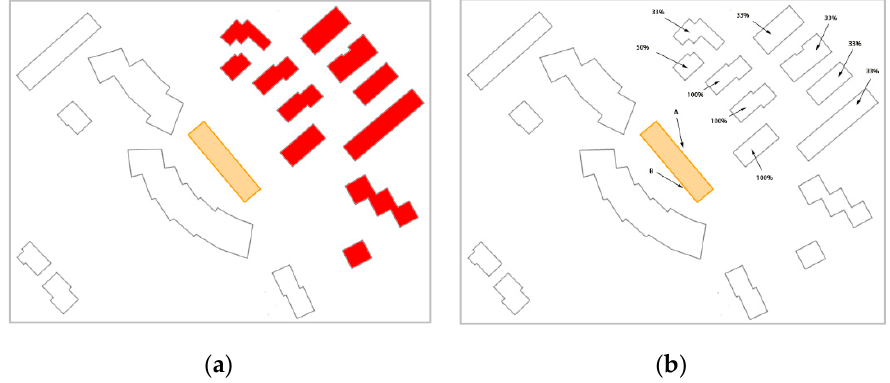
Figure 24 . Results of the front relation with respect to the selected building: ( a ) from the application; ( b ) from the user tests.